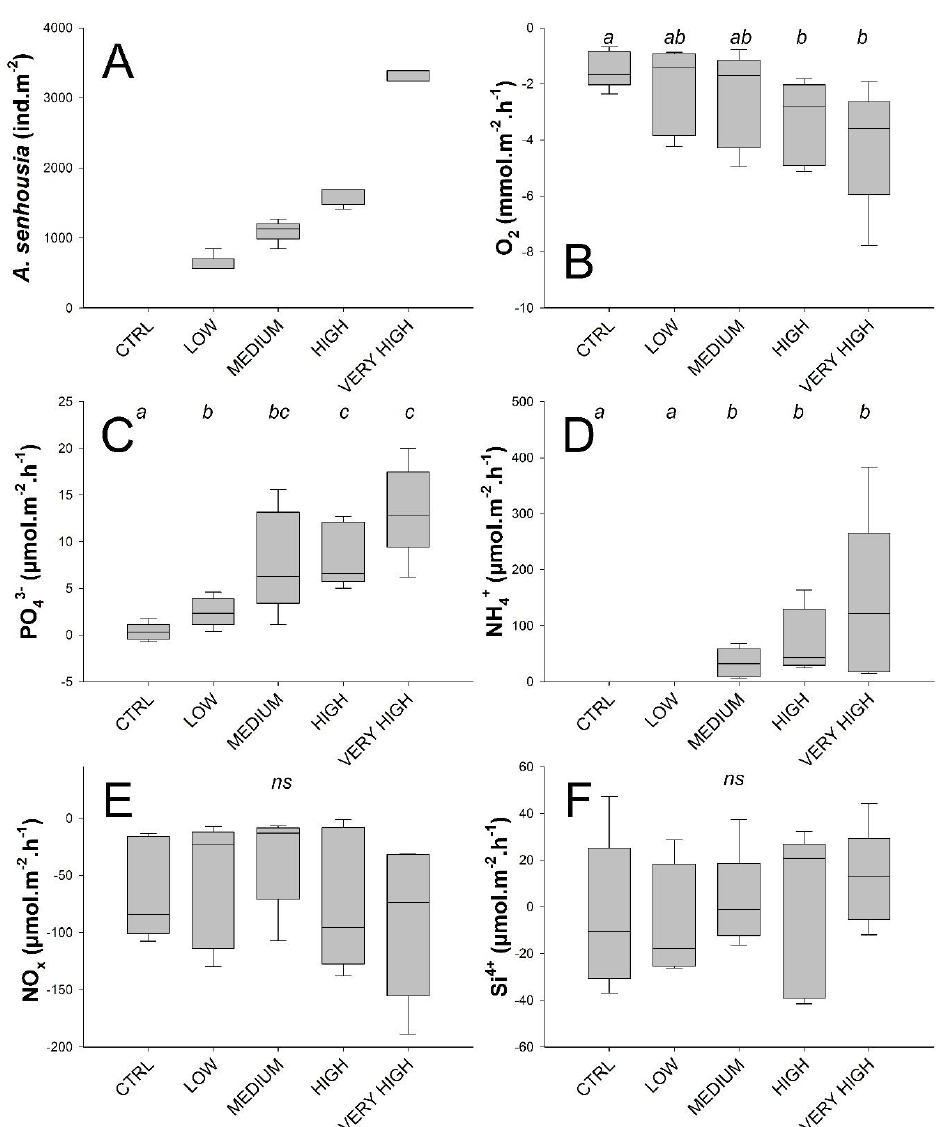
Figure 3. Treatment-wise box plots (Boxes represent 95 % CI and whiskers min and max) showing: